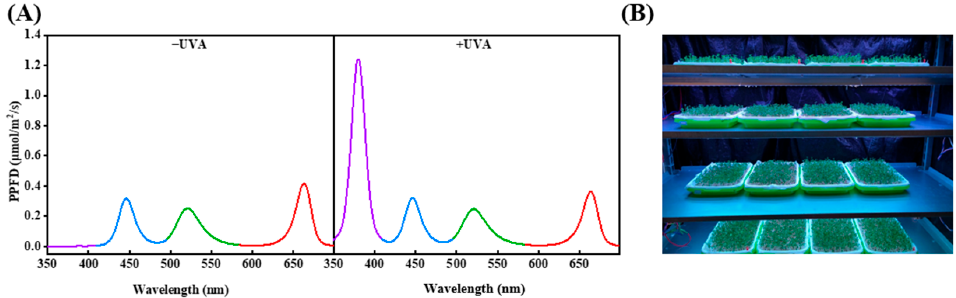
Figure 9. Spectra of light treatments ( A ) and photo of the experimental bench ( B